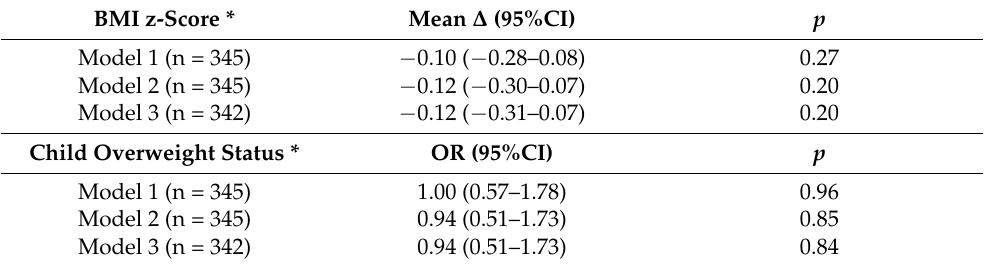
Table 5. Determinants of low dietary fibre trajectory in the Melbourne Infant Feeding Activity and Nutrition Trial Program (n =